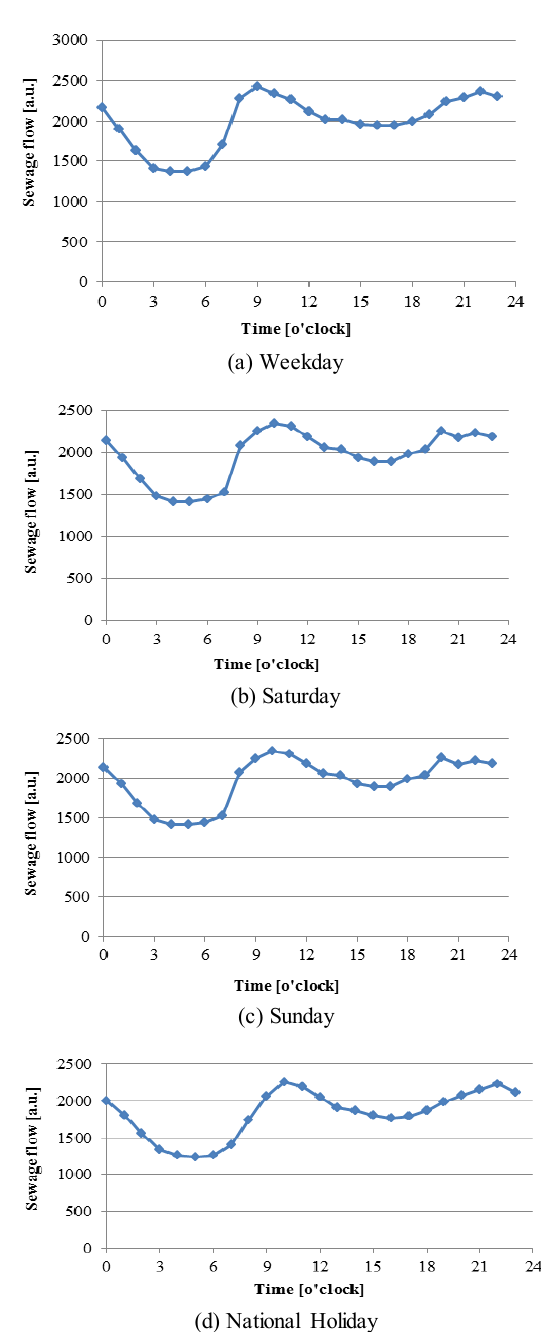
Fig. 3. Typical flow pattern considering day